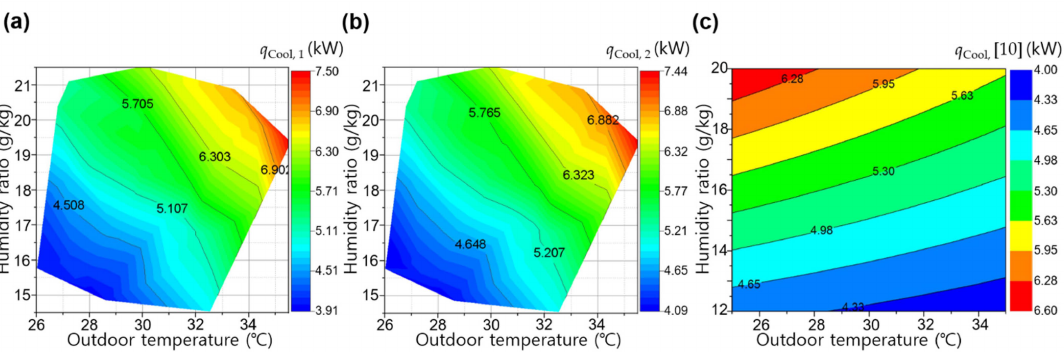
Figure 10. Cooling capacity of ( a ) Unit 1 and ( b ) Unit 2. ( c ) Field test data [10] of cooling capacity for the existing system.